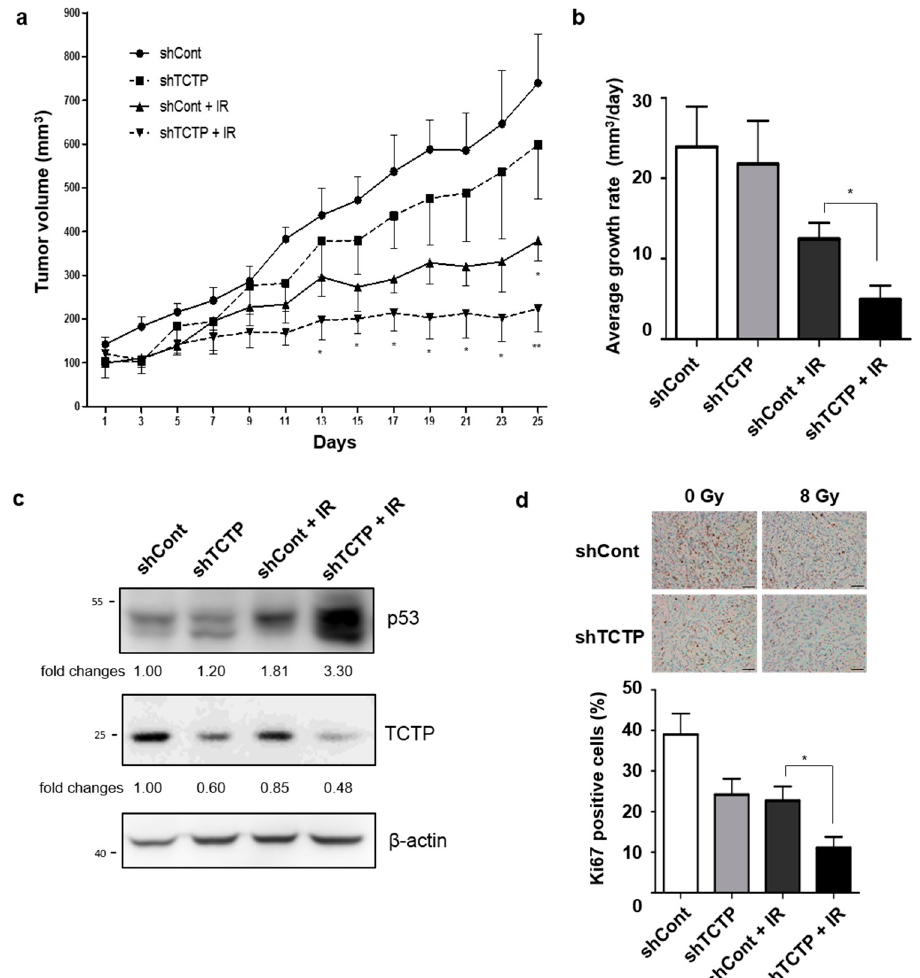
Figure 6. TCTP knockdown enhances radiosensitivity in tumor xenograft mouse model. A549 cells were stably infected with lentiviral control shRNA (shCont) and shRNA vector-targeting TCTP (shTCTP) and introduced to the right thigh of 6-week-old, female, Balb/c nude mice. When the tumors of stably transfected cells reached 100 mm 3 , they were treated with γ -radiation (8 Gy). ( a ) The growth of the tumors was assessed by measuring tumor volume with digital caliper every other day for 25 days. The data represent the mean ± SEM. * p < 0.05, ** p < 0.01 vs. shCont. ( b ) Average tumor growth rate (mm 3 /days) is shown. The data represent the mean ± SEM ( n = 6–8/group). * p < 0.05 ( c ) The immunoblots of tumors from shCont, shTCTP, shCont+IR, and shTCTP+IR groups using anti-p53, anti-TCTP, and anti- β -actin antibodies are shown. The cropped blots are used in the figure and full-length blots are presented in Figure S10. The relative level of proteins in comparison to β -actin are indicated below each immunoblot ( n = 6). ( d ) Immunohistochemistry of the tumors with anti-Ki67 antibody and the percentage of Ki67-positive cells per field are shown. The scale bar indicates 50 µ m (magnification: 200 × ). The data represent the mean ± SEM. * p < 0.05.